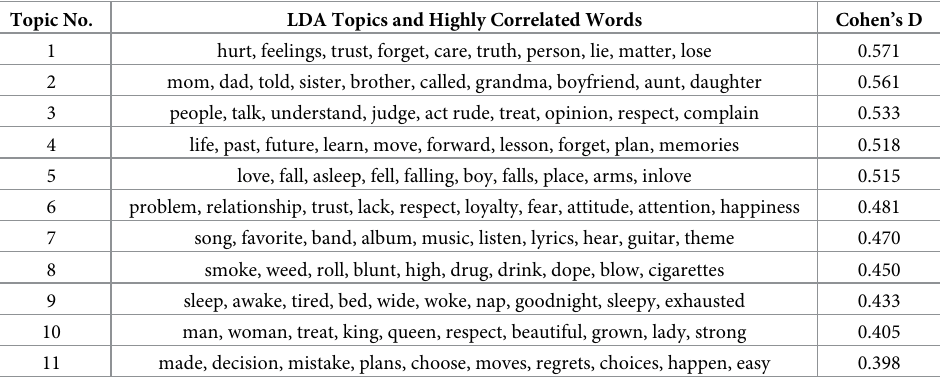
Table 11. Results from LDA analysis for female: 30—65. Topic No. LDA Topics and Highly Correlated